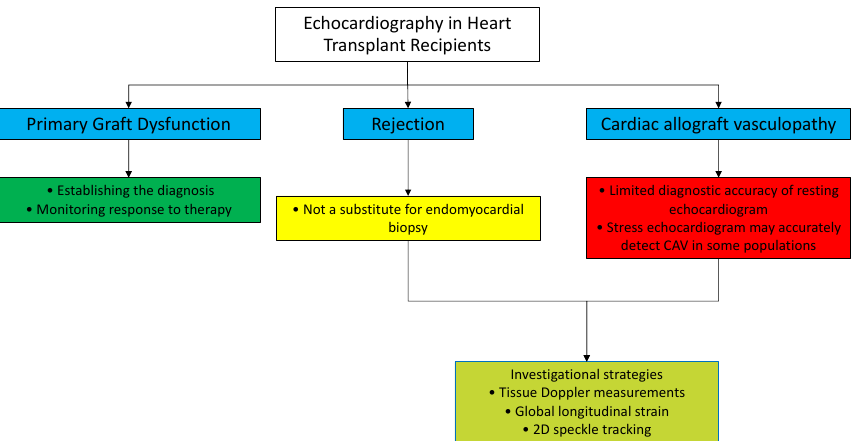
Figure 5. Role of echocardiography in HTRs. CAV: cardiac allograft vasculopathy.